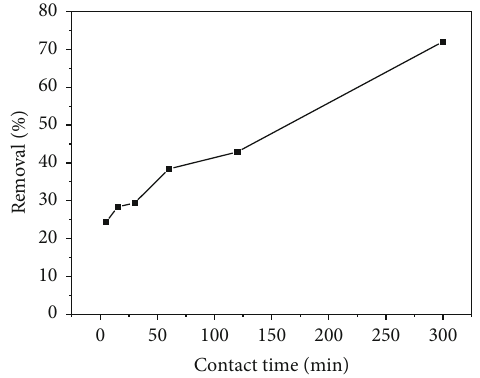
Figure 2: E ff ect of the contact time on the removal of iron (III).